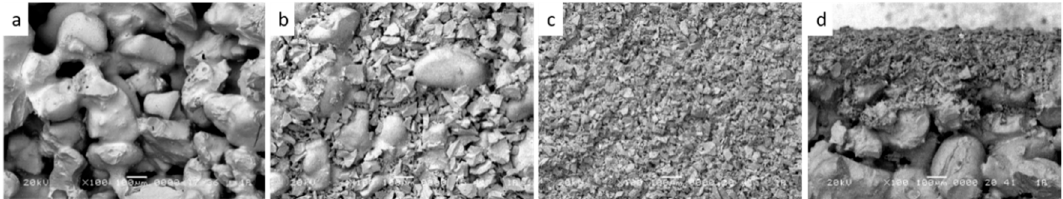
Figure 4. SEM image of quartz sand-based membrane composed of three layers. Surface image of ( a ) Support, ( b ) intermediate, and ( c ) active microfiltration layer; ( d ) cross-section of the whole membrane. Using different fractions of natural quartz sand, it is possible to fabricate support and the active layer of membranes (adapted from ref. [101] with permission from Elsevier).